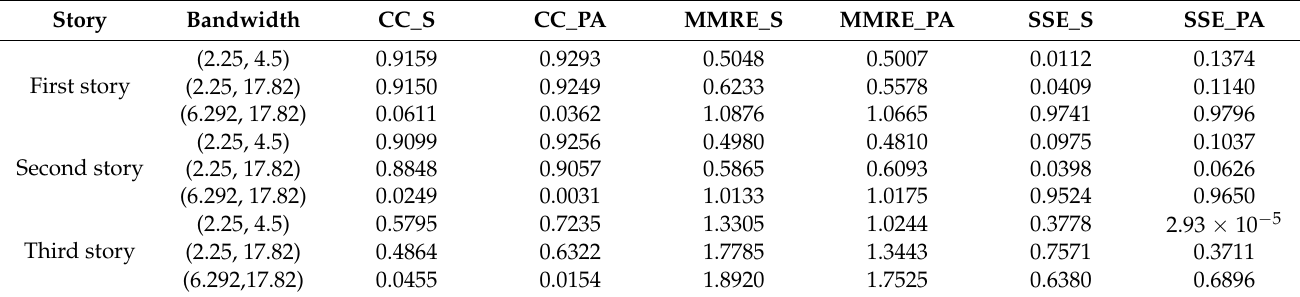
Table 4. Error analysis of IDs versus LDS for the undamaged